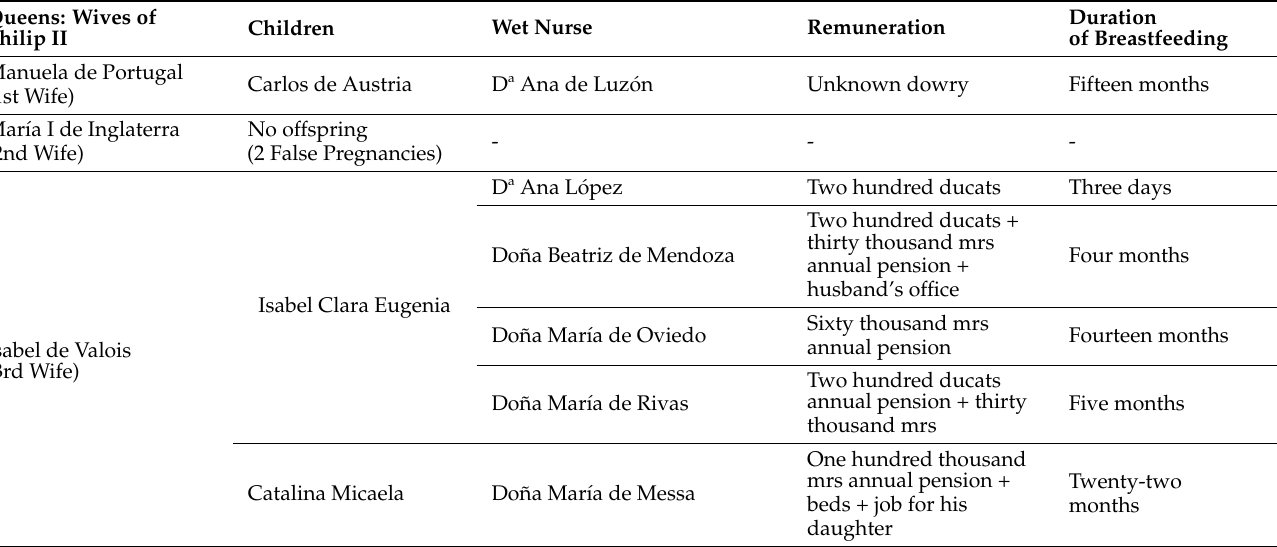
Table 4. Queens/wives of Philip II and their children as well as wet nurses and their